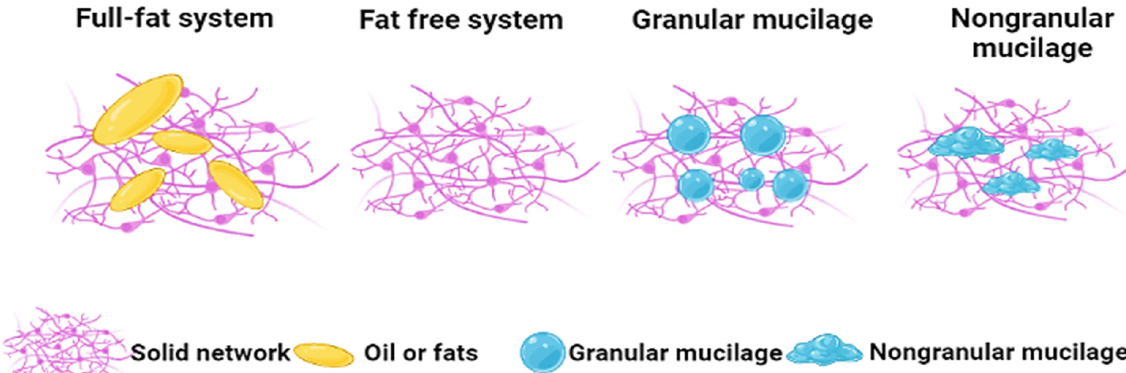
Figure 4. Application of taro mucilage as a fat replacer in bakery products.